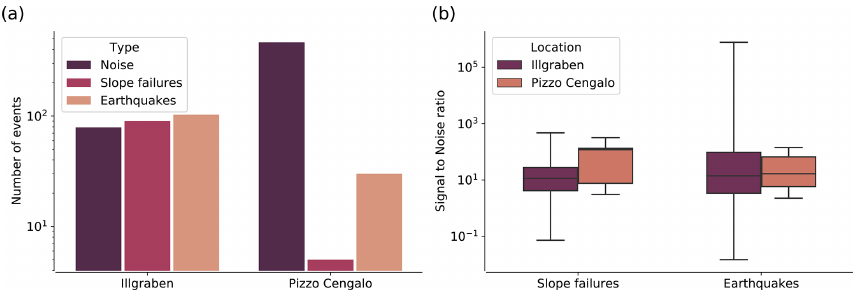
Figure 3. (a) Bar chart with events per class for both the Illgraben and the Pizzo Cengalo data set. (b) Boxplot of SNRs of all slope failure and earthquake events at Illgraben and Pizzo Cengalo. The boxes denote the quartiles (25–75%), the black horizontal line denotes the mean, and the black vertical error bars indicate